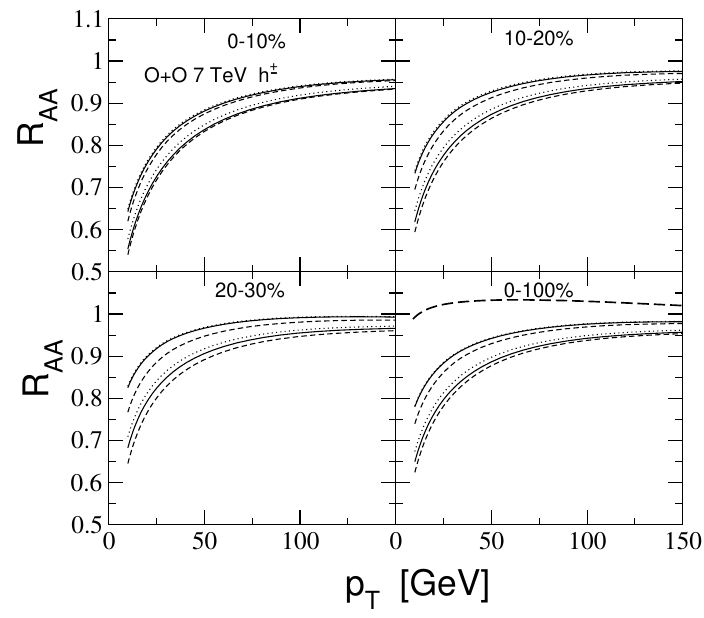
Figure 11 . Same as in figure 10 (but now without dash-dotted lines) for 7 TeV O+O collisions.